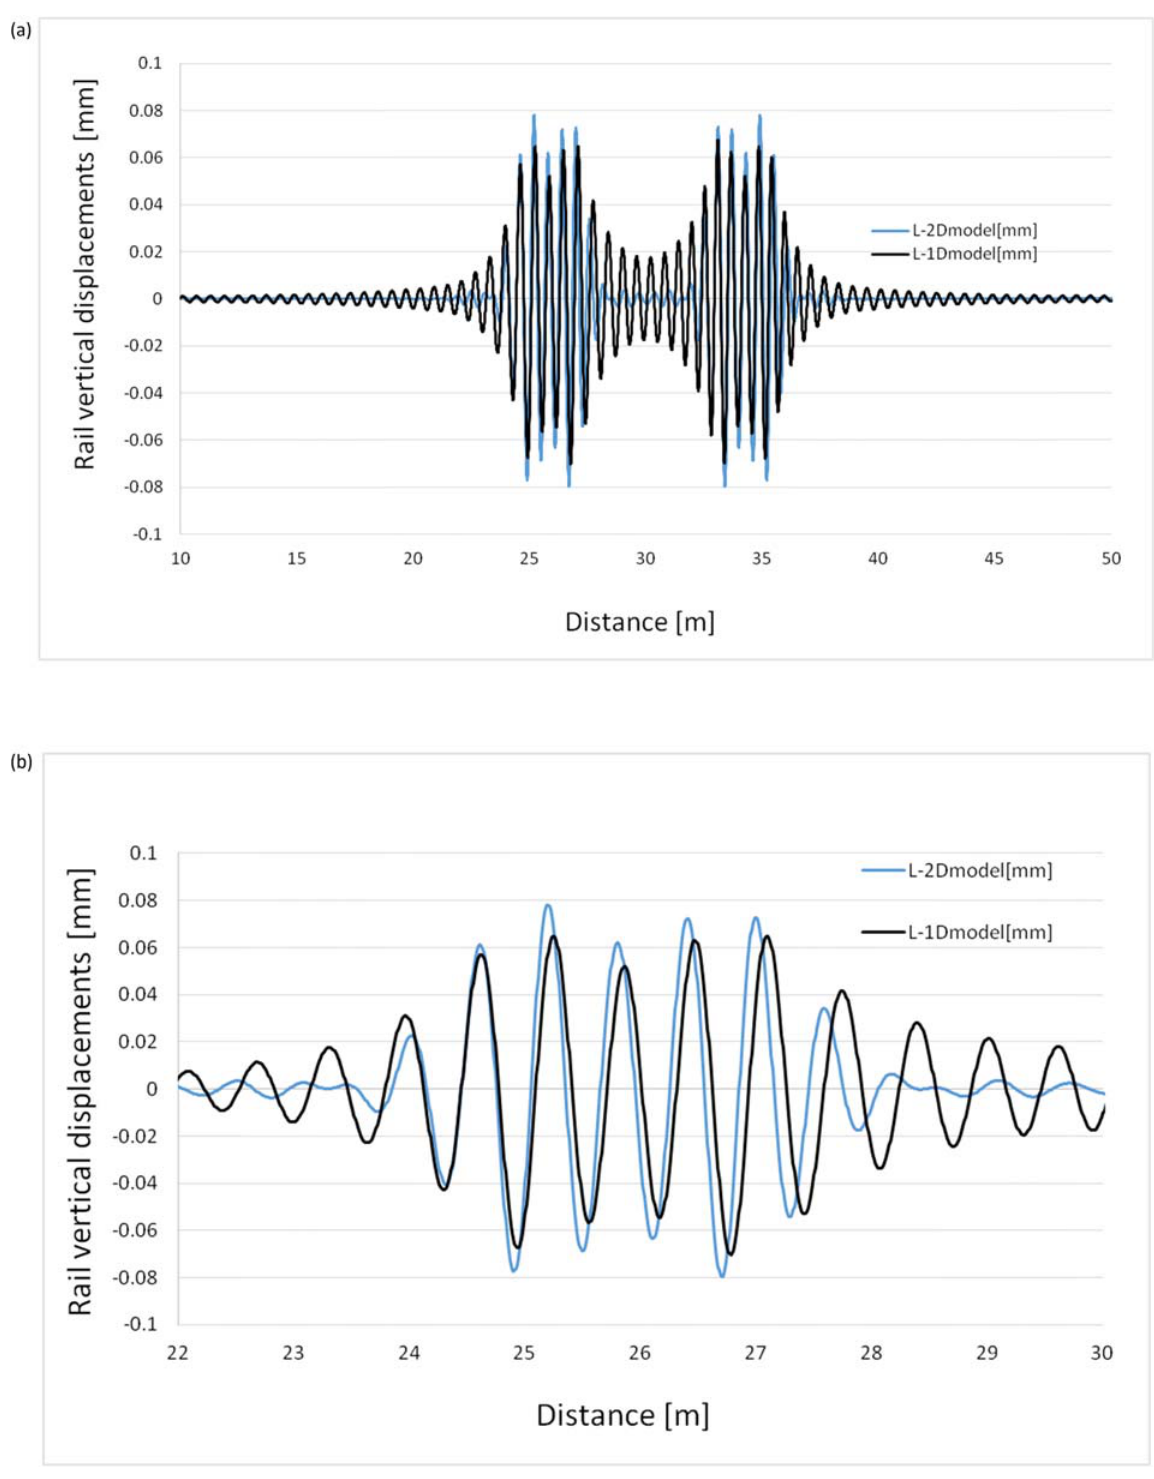
Figure 5: ( a ) Whole rail displacements for a two - layer ( L - 2D model ) and a one - layer ( L - 1D model ) models ( coal wagon, v = 100 km/h, k = 91.1 MPa, imperfection s = 10 μ m, and L r